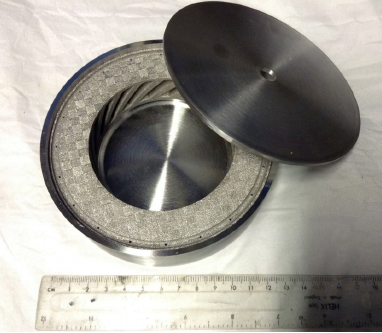
Figure 3. An image of three parts before assembling.